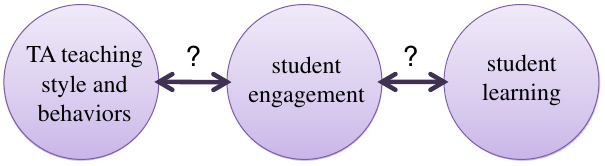
FIG. 1. A simplified model of the TA – student